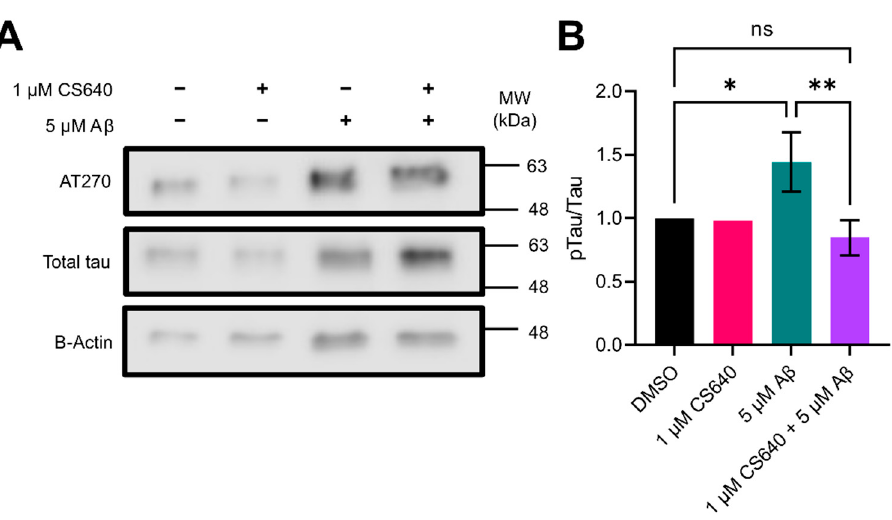
Figure 6. Relative abundance of phosphorylated tau in mouse primary neuronal cell cultures. ( A ) A representative western blot showing the relative abundance of tau phosphorylated at Thr181 (AT270), total tau, and β -Actin in the absence and presence of 1 µ M CS640 and/or 5 µ M A β 1–42 . ( B ) Relative abundance of tau phosphorylated at Thr181 (AT270) over total tau in the absence and presence of 1 µM CS640 and/or 5 µM A β 1–42 , calculated from quantifications of three replicates of western blots. Error bars represent standard deviation. Only one replicate of 1 µM CS640 alone was performed, and it is thus excluded from the statistical analysis. ns = not significant. ns p = 0.5004, * p = 0.0318, ** p = 0.0085.